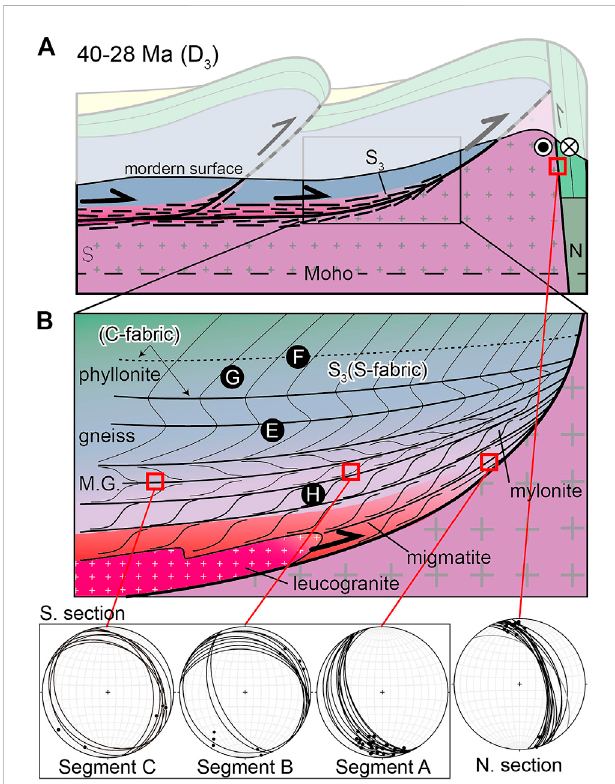
FIGURE 7 Schematic diagram with southern hemisphere equal-area projection stereonet diagram showing geographical distribution of reconstructed S 3 foliation with various dip and metamorphic conditions of the D 3 fold and thrust complex. (A) Sub-horizontal to gentle back-limb produces a signi fi cant horizontal shearing and folding at higher metamorphic conditions. The steep fore-limb developed the sub-vertical strike-slip fault against the boundary of the Baoshan block as theOrdovicianbasement preventedstress penetration. (B) Schematic diagram showing the structural pattern and relative outcrop altitude labeled as a black circle with text, which correspond to the outcrop photos in Figure 3. The distribution of rock types changed from leucogranite, migmatite, migmatiticgneiss [M.G.], gneiss, and phyllonite toward the top. A higher strain is observed for the lower portion under higher metamorphic conditions. The red square marks the relative position of S 3 foliation measurements, showing sub-horizontal to steep NE-dipping